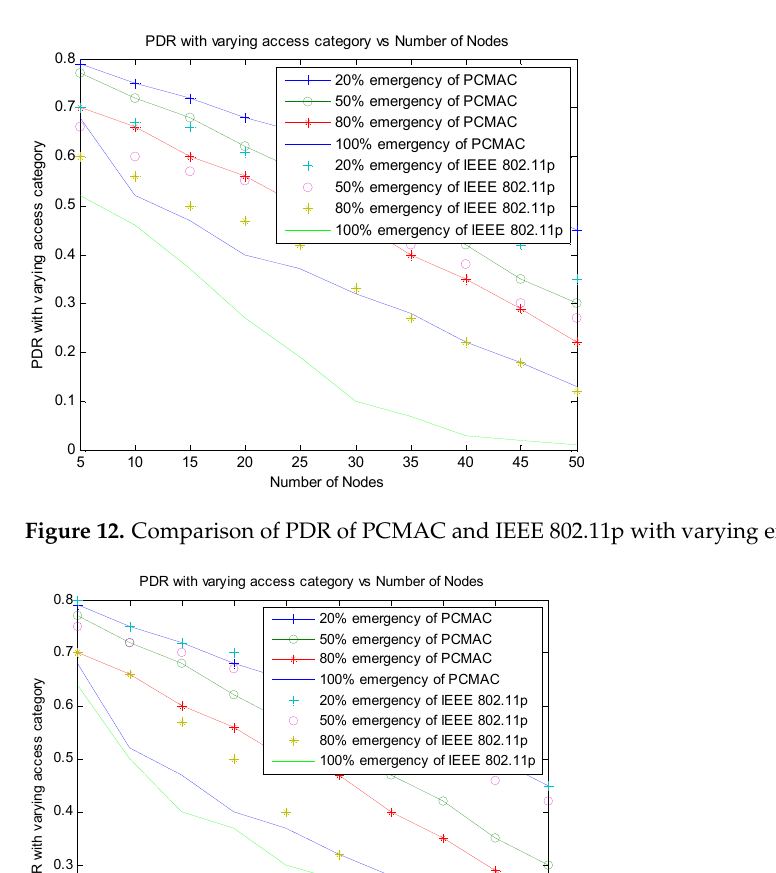
Figure 12. Comparison of PDR of PCMAC and IEEE 802.11p with varying emergency packets.